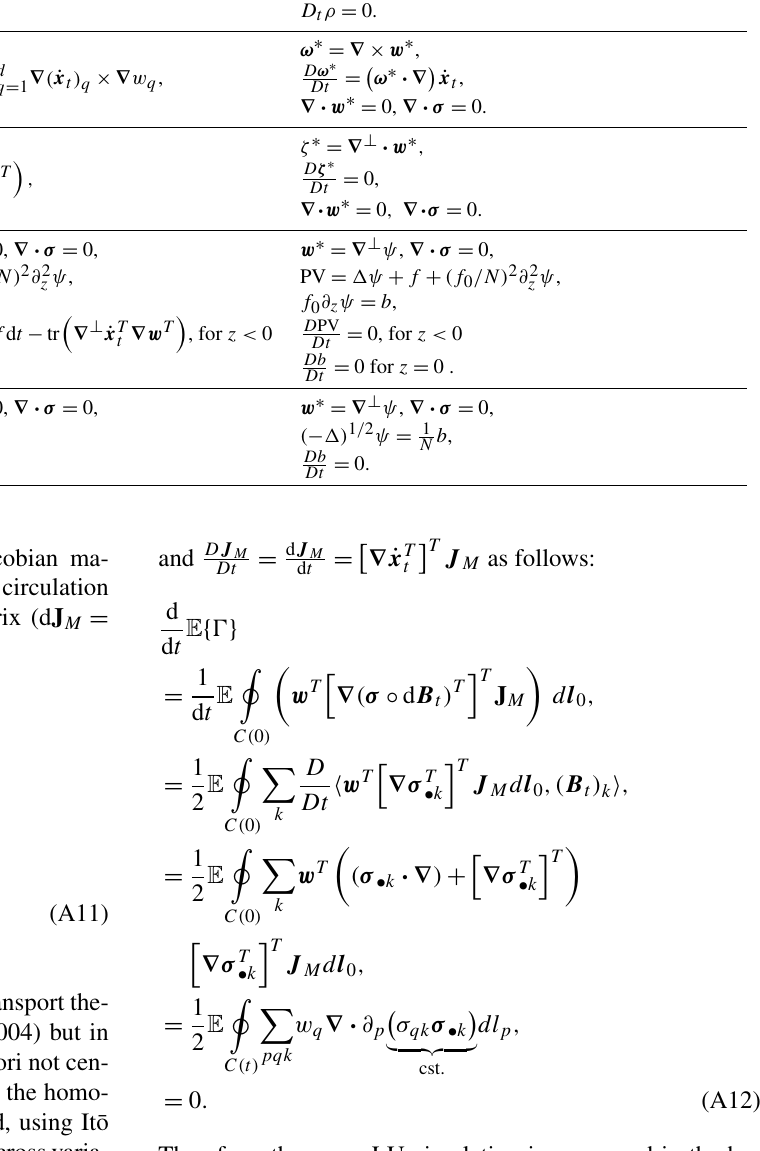
Table A2. Some LU and SALT dynamics models with Stratonovich notations. Equations LU SALT 3D Euler equation in a